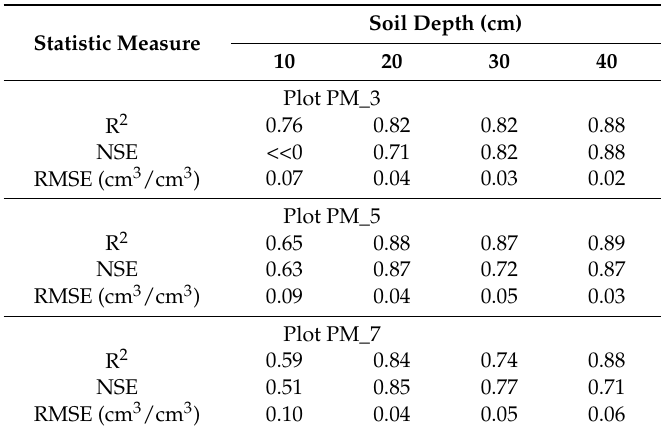
Table 5. Calibrated van Genuchten hydraulic parameters for the different plots at the middle zone of the floodplain.